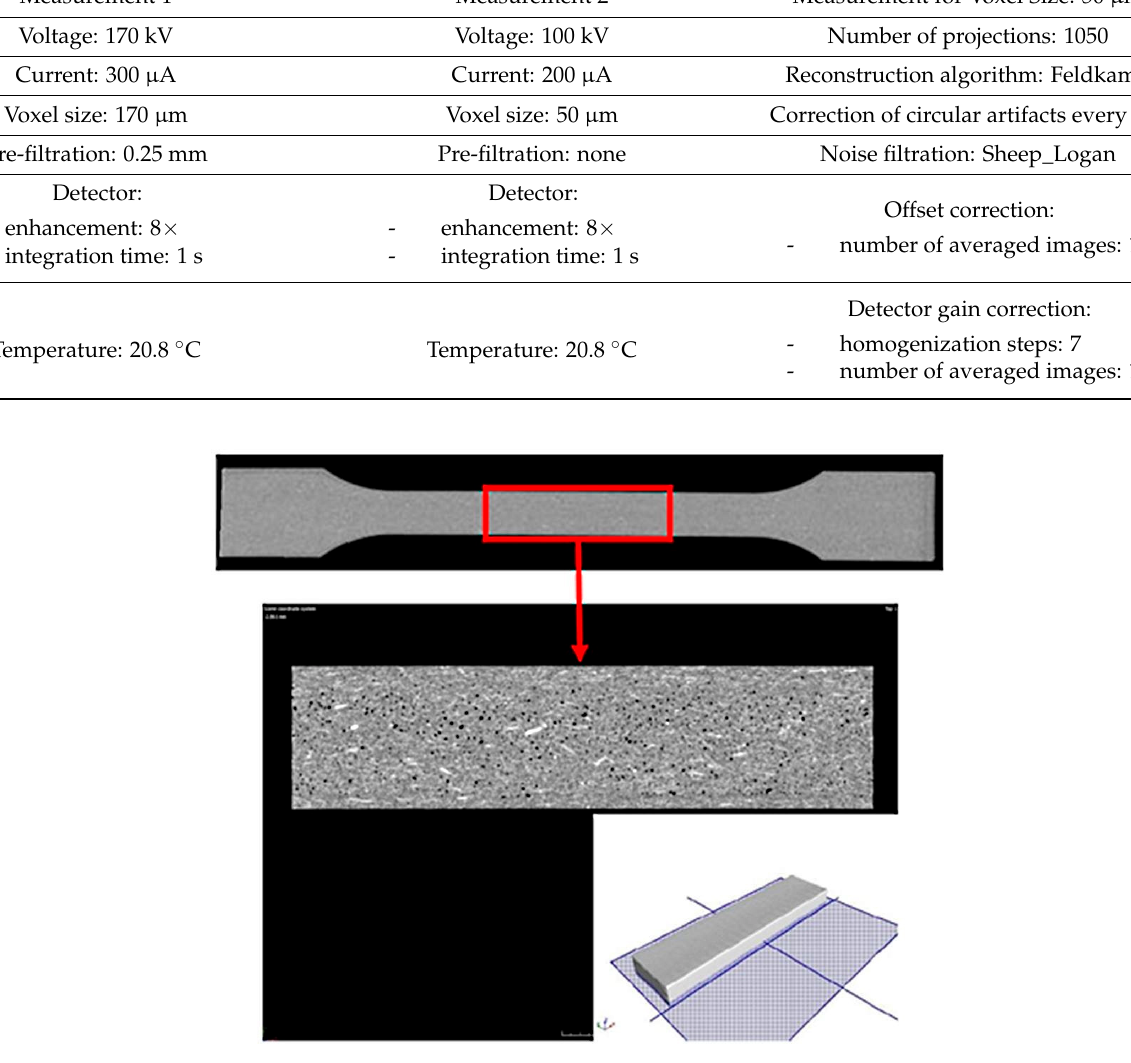
Figure 1. Sample test result using computed tomography with a resolution of 170 µm and a cho- the